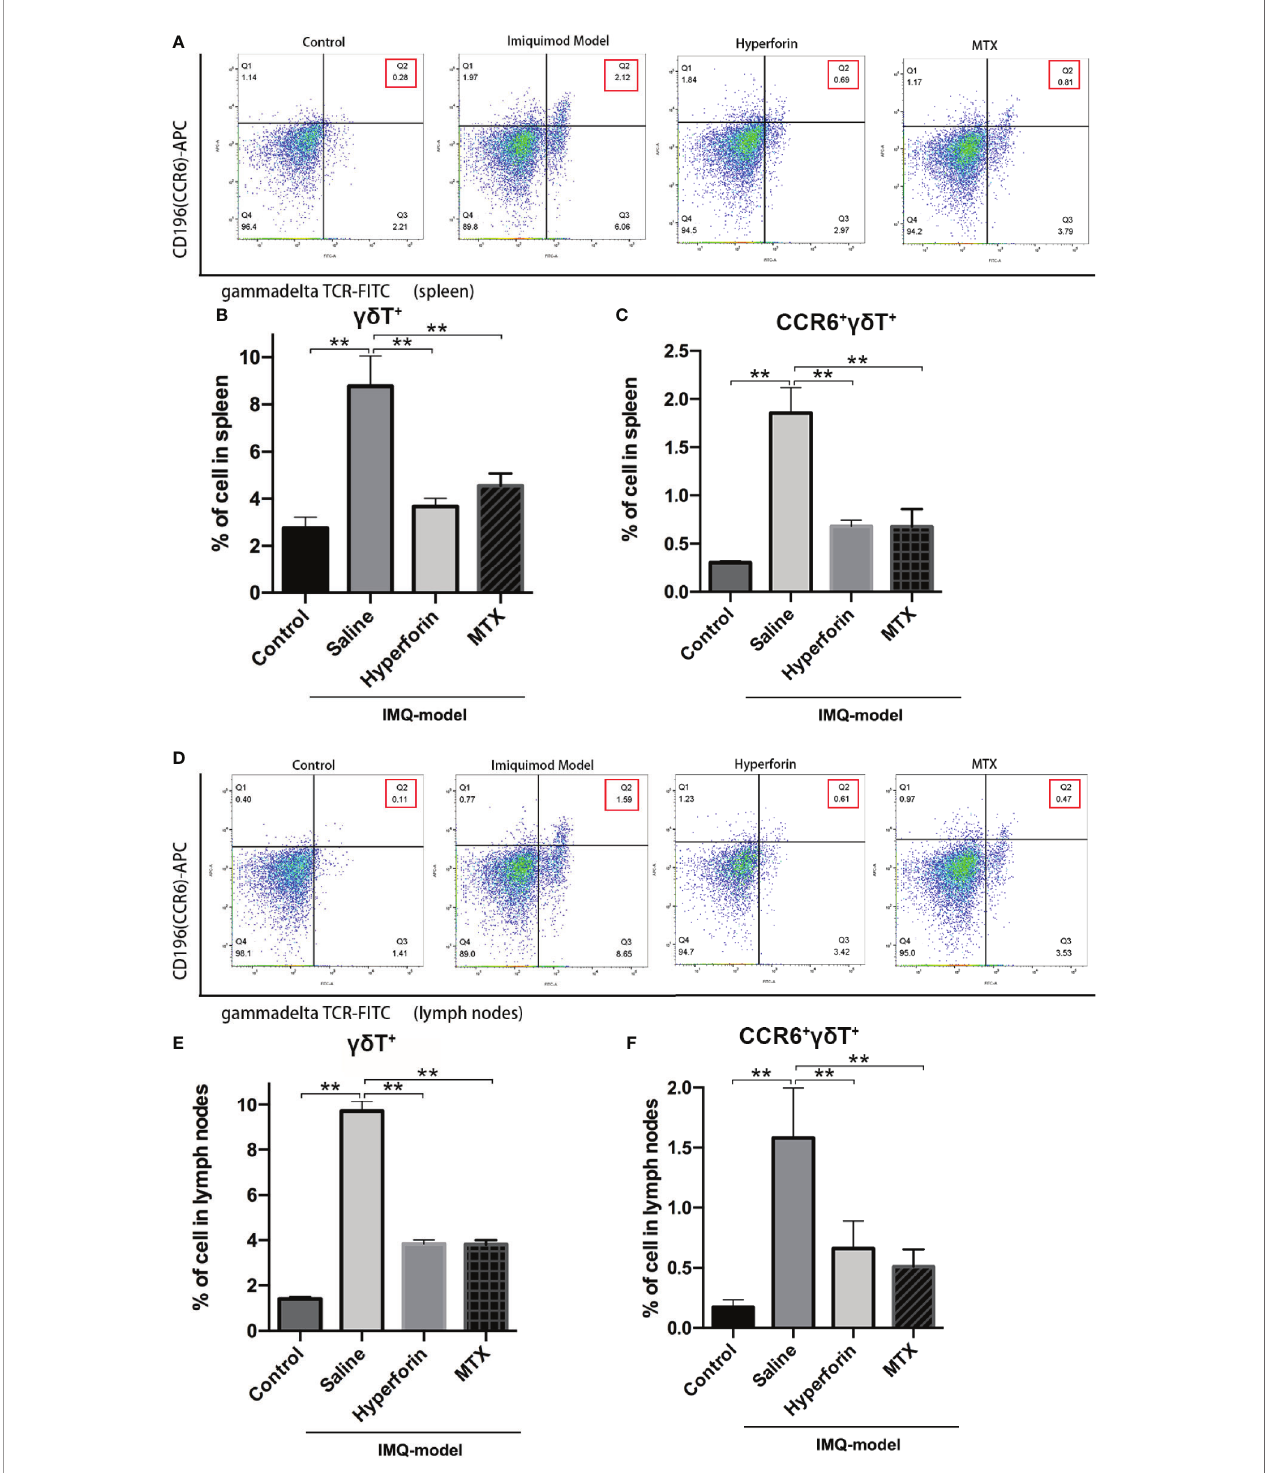
FIGURE 4 | Hyperforin reduced the abundance of gd T cells in the spleen and lymph nodes of psoriasis-like mouse model. The percentage of gd T cells and CCR6 + gd T cells in the total live cells in spleen (A – C) and axillary lymph nodes (D – F) . (n=5 mice). *P < 0.05 and **P < 0.01 vs model